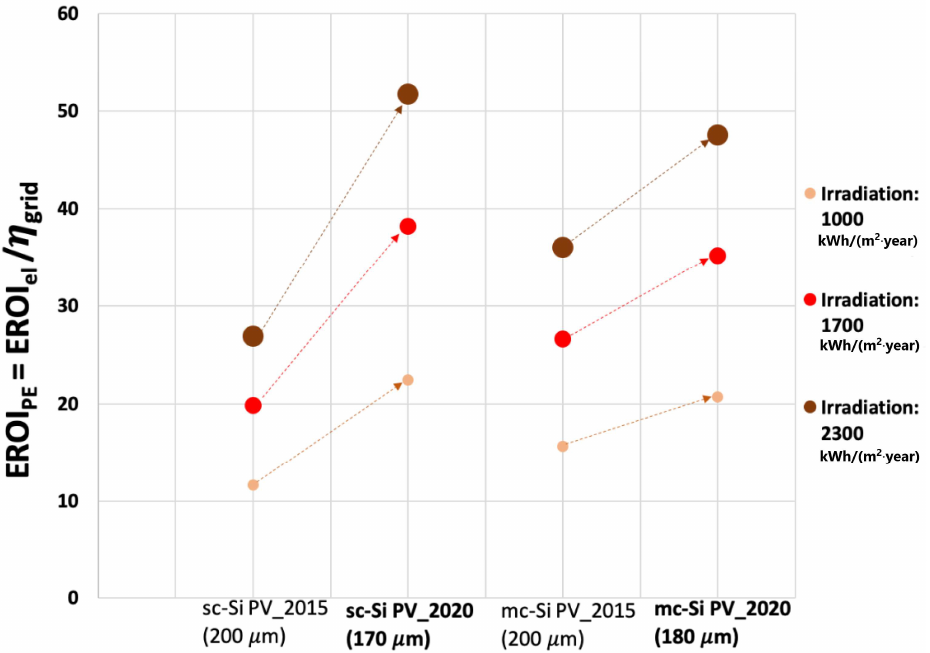
Figure 3. EROIs increases from 2015 to 2020, under three irradiation levels: 1000 kWh/(m 2 · year), 1700 kWh/(m 2 · year) and 2300 kWh/(m 2 · year). Assumed η grid = 0.30; lifetime = 30 years. Per- formance ratio: 0.85. Efficiencies: 17% and 20.5% for 2015 and 2020 single-crystalline Si (sc-Si) photovoltaic (PV), respectively, and 16% and 18% for 2015 and 2020 multi-crystalline Si (mc-Si) PV, respectively–from Fthenakis and Leccisi